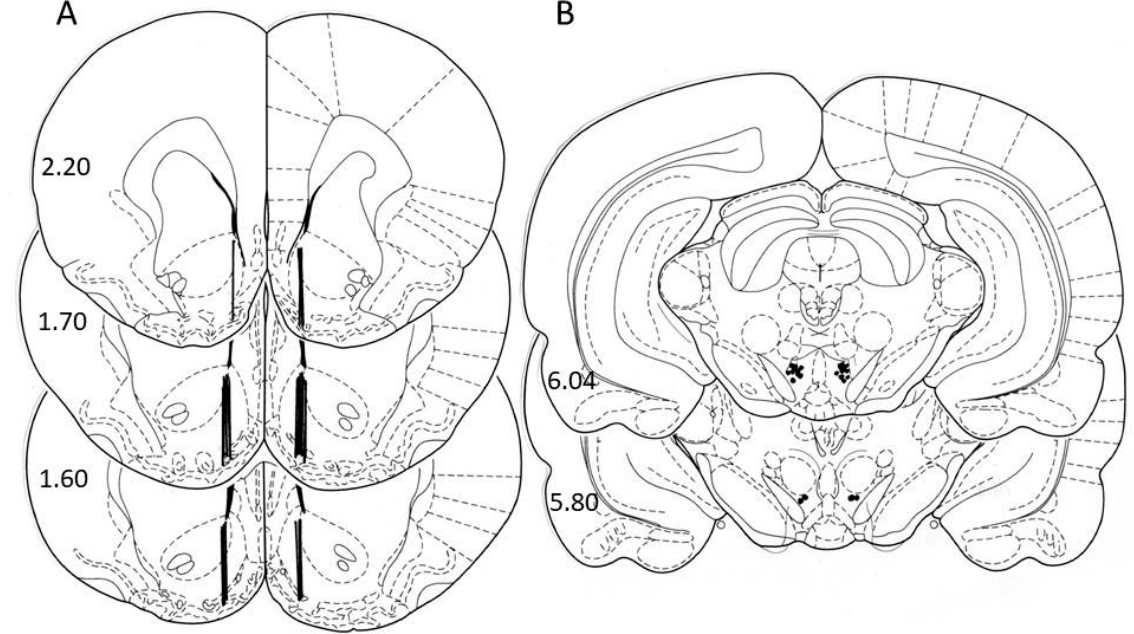
Figure 5. Schematic locations of dialysis probes in the nucleus accumbens shell ( A ); sites of infusions into the ventral tegmental area ( B ). Schematic locations of probe tips in animals which were involved in statistical analyses of accumbens neurotransmitter concentrations (the bold lines indicate the dialyzing positions in Figure 4A and locations of WIN55,212- 2/vehiculum solution administrations into the VTA (dark dots in the lower part of slices in Figure 4B) as described in the atlas of Paxinos and Watson [77]. The distance from bregma (in mm) is indicated on the left of each sectional